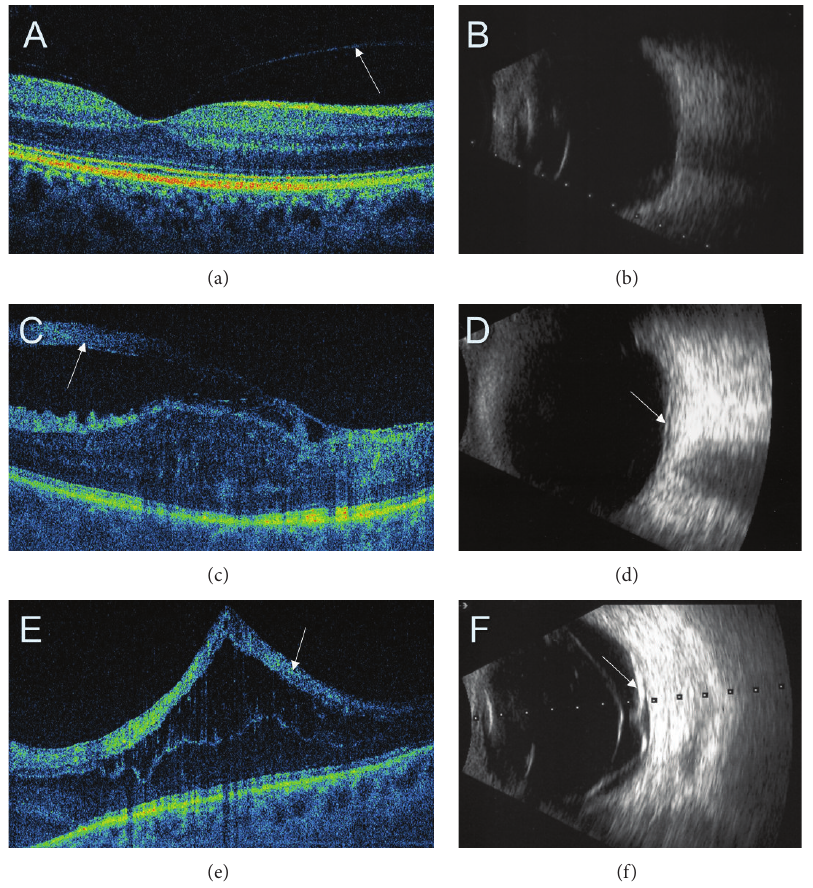
Figure 7: Comparison of retinal SDOCT (a, c, e) with ultrasonography (b, d, f). (a) Perifoveal posterior vitreous detachment (arrow) (PVD). (b) No PVD is detectable on ultrasonography. (c, d) A thick preretinal fibrosis (arrows). (e, f) Tractional macular detachment